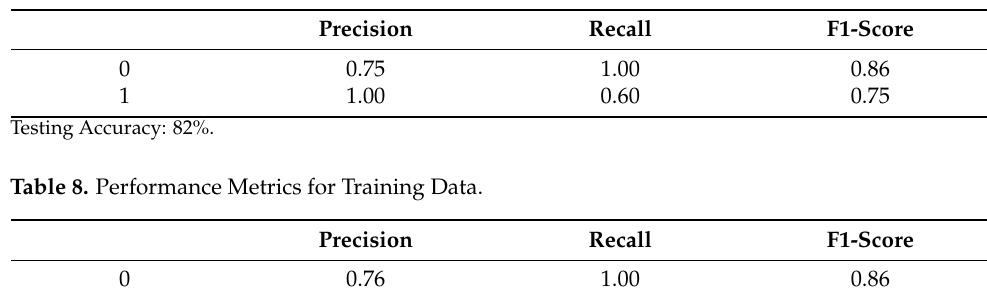
Table 7. Performance Metrics for Testing Data.